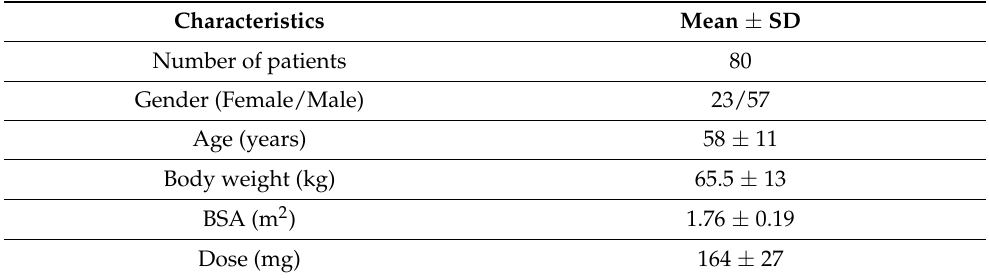
Table 1. Patients’ characteristics. SD: standard deviation. All patients were hospitalized for head and neck cancer.